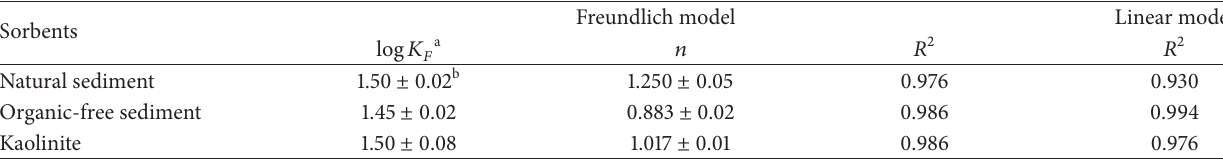
Table 2: Isotherm parameters of phenanthrene sorption on the sorbents.